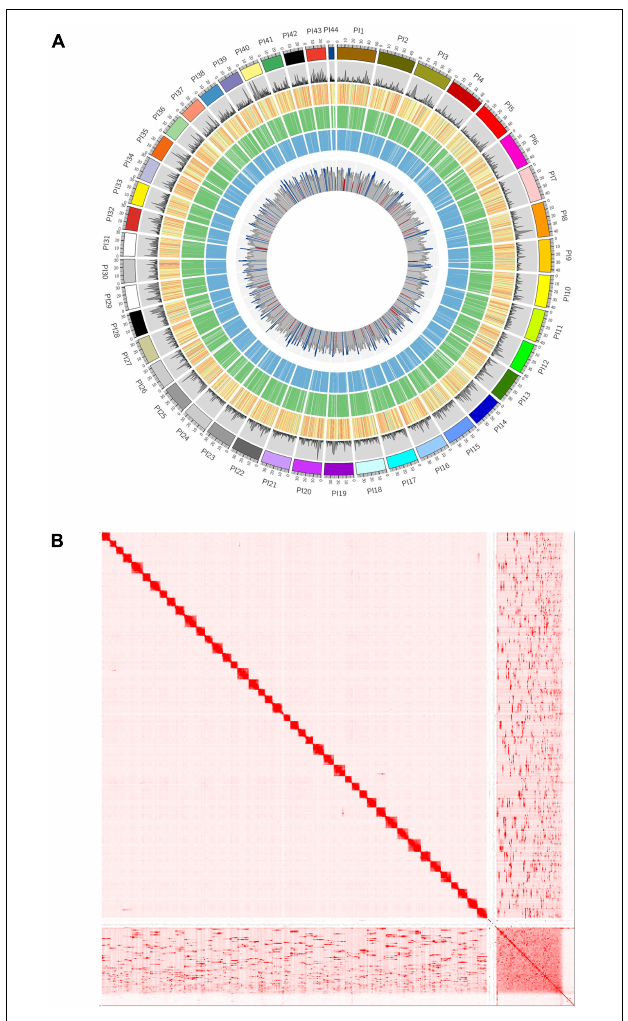
FIGURE 1 | Assembly of P. indicus genome. (A) Circos plot depicting the properties of 44 pseudochromosomes. Track 1 (outer-most): the 44 pseudochromosomes. Track 2: line diagram of contigs with peaks indicating the size of contig. Track 3: protein-coding genes plotted as heatmap with progressive colors (yellow–orange–red) indicating length of genes. Track 4: protein-coding genes on positive strand. Track 5: protein-coding genes on negative strand. Track 6 (innermost): GC content of the genome as a histogram in gray color, here GC values < 30 are shown in red and > 40 are shown in blue. (B) The longest scaffolds representing the pseudochromosomes as obtained with 3D-DNA